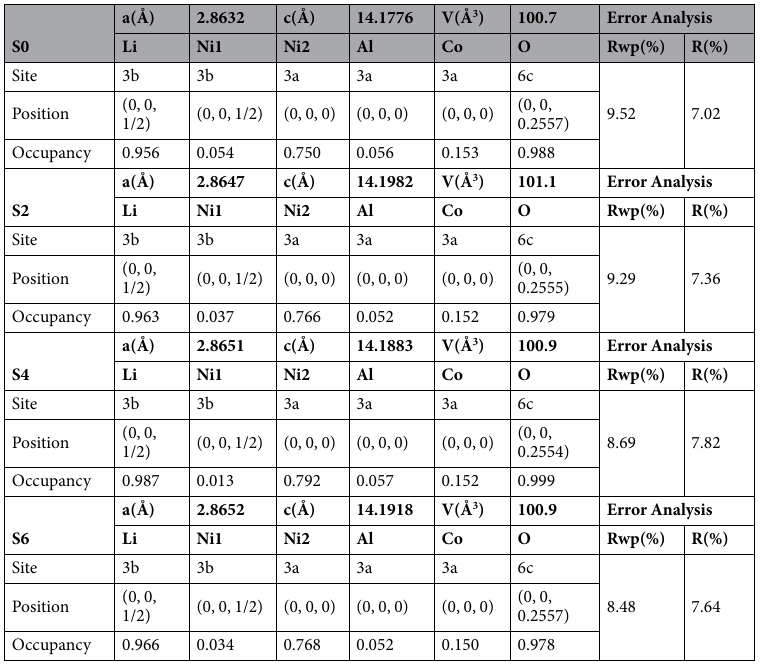
Table 1. Result of structural Analysis Obtained from X-ray Rietveld refinement of the